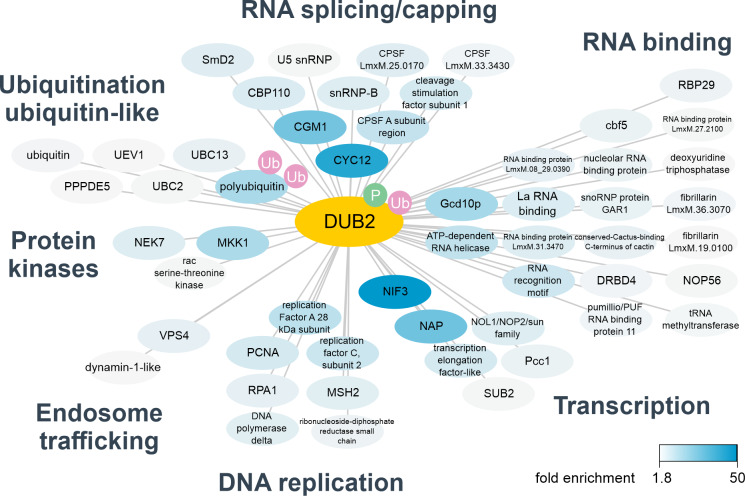
DUB2 interactome.Summary of detected DUB2 interactions. Myc-DUB2 was immuno-precipitated from promastigotes and binding partners identified by label free quantitative mass spectrometry. Interaction data were analysed with SAINTq, high confidence interactors (<1% FDR) were selected and are shaded according to fold enrichment against a control immuno-precipitation. Detected ubiquitination sites (Ub) and phosphorylation (P) are shown. Interactors are grouped according to the annotated function. A total of 110 high confidence interactors were identified. Non-annotated or ribosomal proteins have been omitted for clarity.